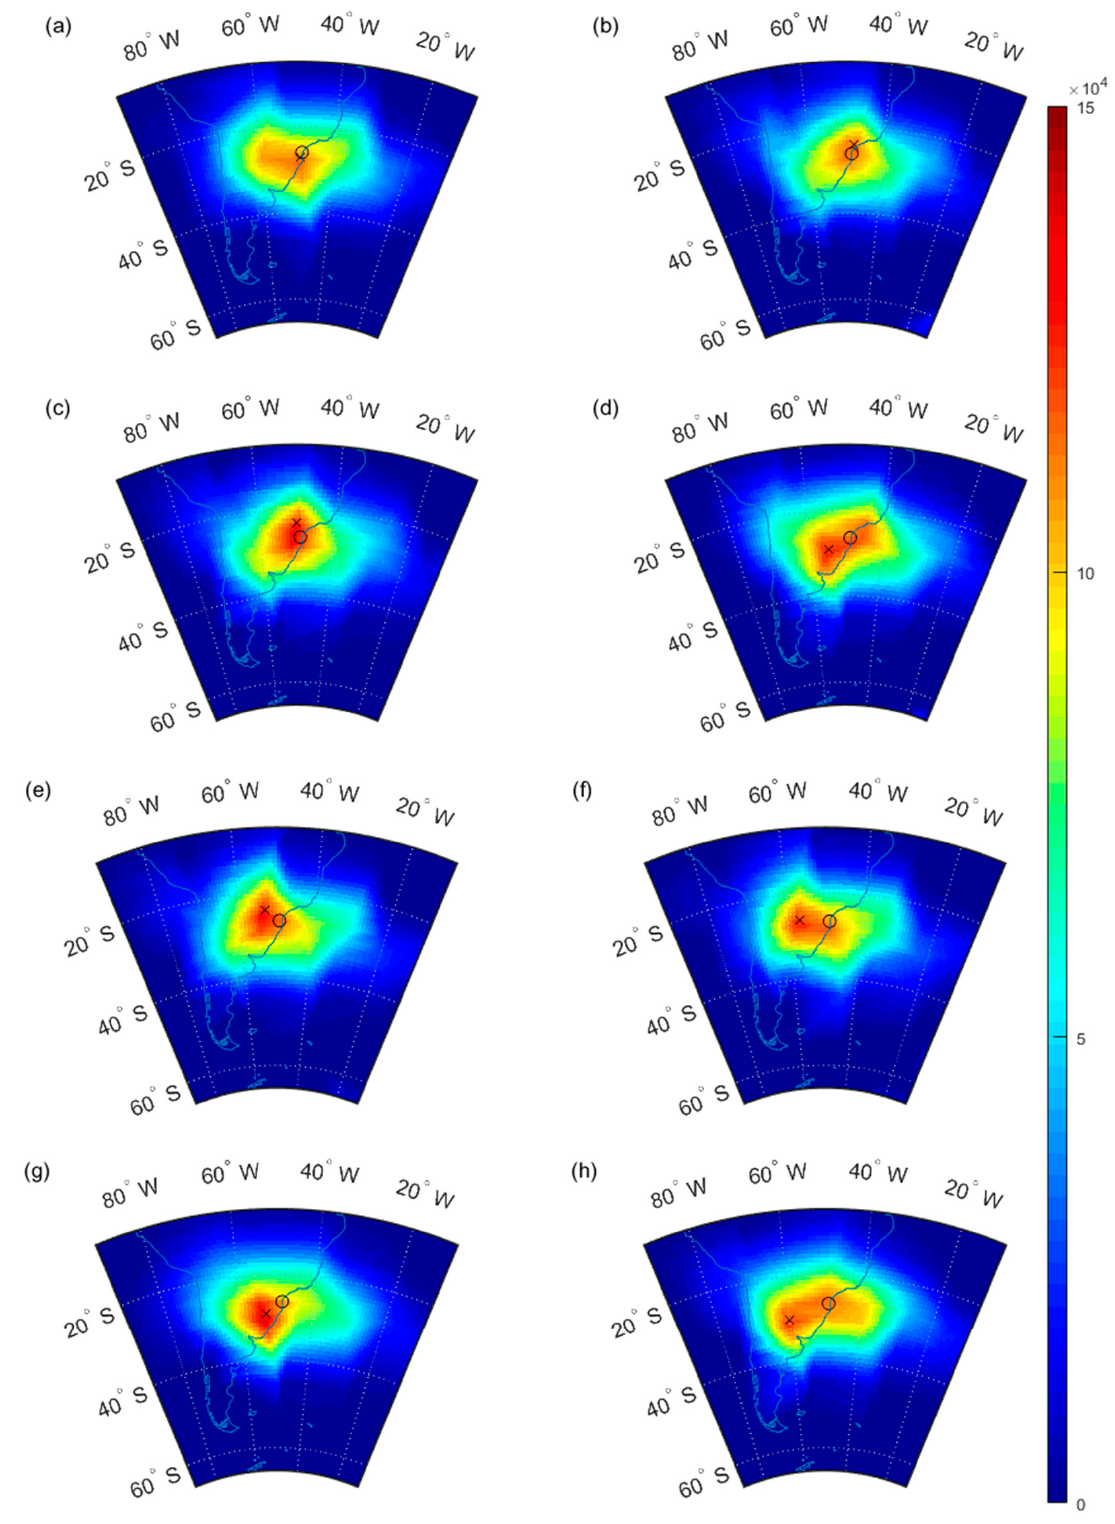
Figure 6. Development of the radiation field (CPM) in the SAA over measurements with the positions of the maximum of radiation (cross) and centroid (circle). ( a ) 30 August 2019; ( b ) 30 September 2019; ( c ) 27 March 2020; ( d ) 10 October 2020; ( e